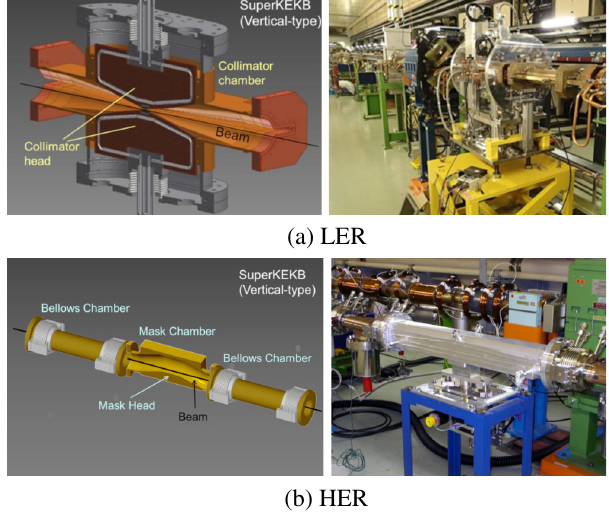
FIG. 27. Typical damaged head in a vertical collimator, where the traveling direction of the beam is from left to